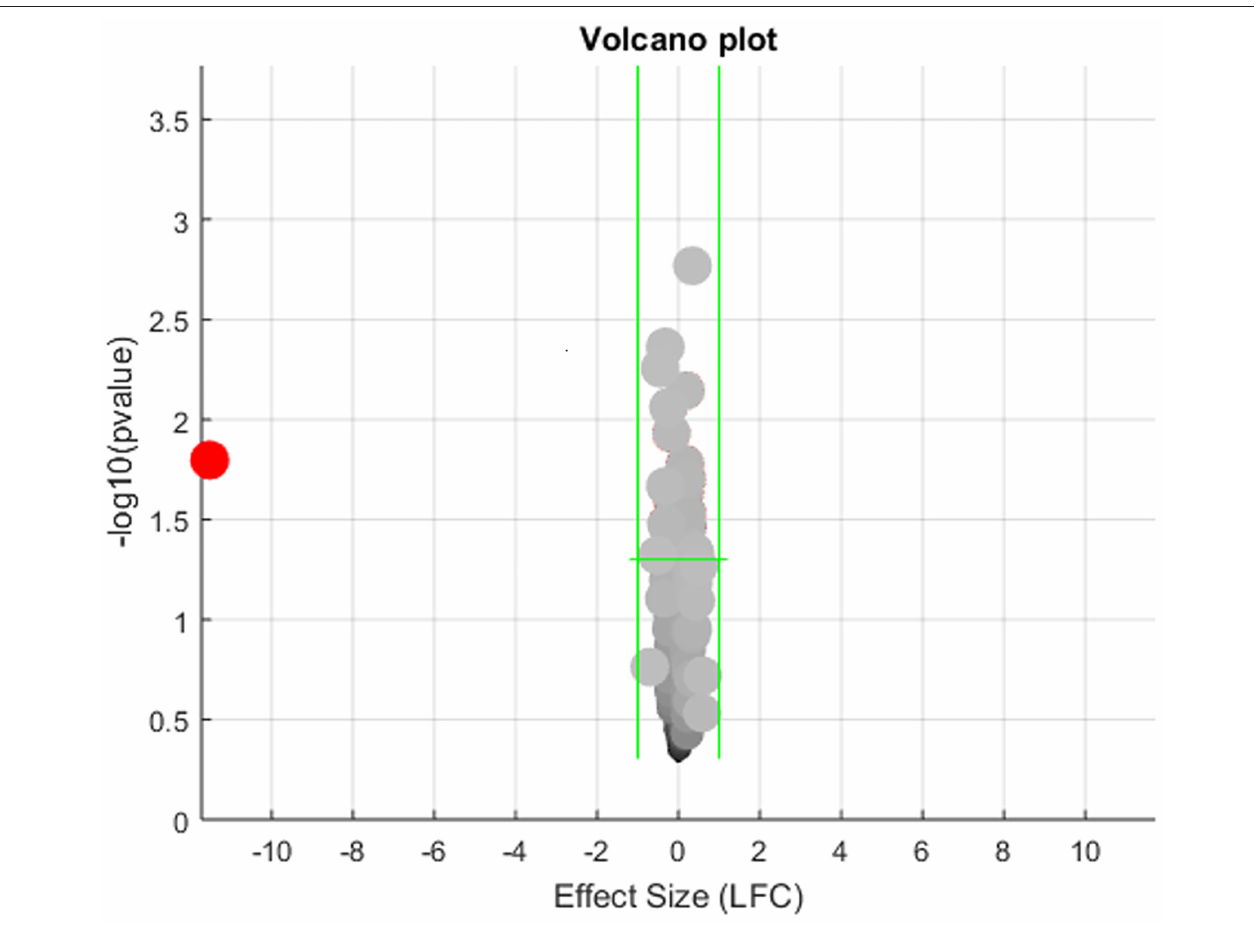
FIGURE 3 | Volcano plot of the mega-analysis results on the 472 obesity regulators but not implicated with myocardial infarction.